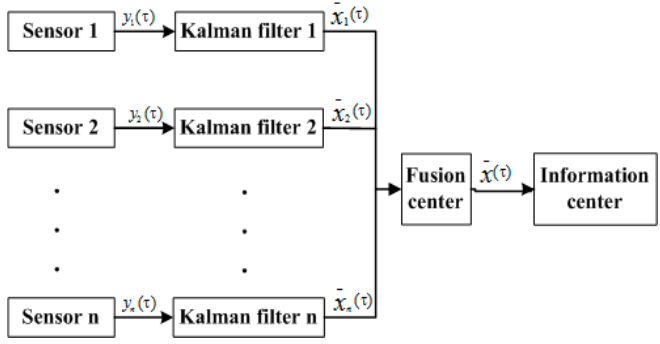
Figure 8. Federal filter information fusion structure.